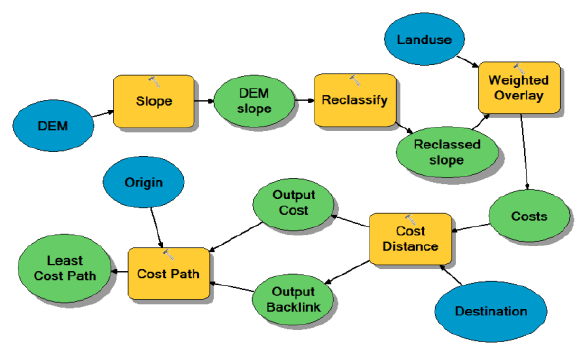
Figure 3: Process model for computing the least cost path